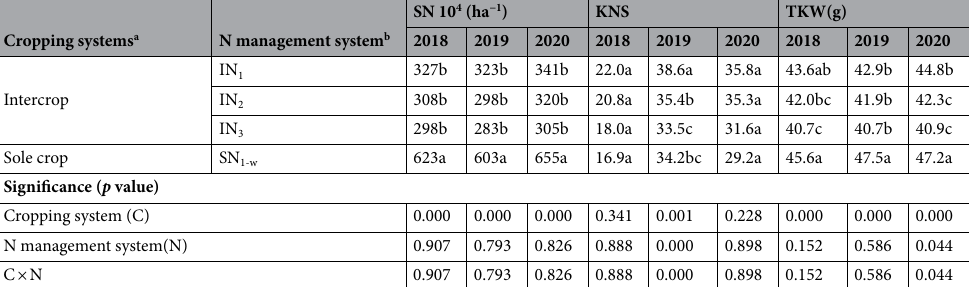
6.2–11.1% and 11.1–17.6% lower than sole maize. The SN of sole maize with the SN 1-m and SN 2-m were promoted by 8.5% and 7.0%, the KNS by 14.9% and 5.7%, and TKW by 5.7% and 3.5% compared with SN 3-m treatment, respectively. The same trend was found in intercropping maize. The SN of intercropped maize under IN 1 and IN 2 were 24.8% and 15.5% higher than IN 3 , the KNS were 12.0% and 7.7%, and TKW were 11.9% and 9.5%, respectively. Harvest index of wheat and maize. Harvest index (HI) of wheat and maize was significantly affected by cropping system and N-fertilizer treatment (except for wheat), but not by their interaction (Fig. 7). The HI of intercropped wheat with IN 1 and IN 2 was 5.9% and 2.6% greater than IN 3 , and of intercropped maize was 5.3% and 3.6% with IN 1 and IN 2 compared with IN 3 . The HI of sole maize with SN 1-m and SN 2-m was 6.9% and 3.9% higher than that of SN 3-m . The HI of sole wheat was lowest, only reached to 0.40. Among the three N treatments, IN 1 and IN 2 increased the HI of intercropped wheat and maize. Path analysis. The correlation coefficients between the grain yield and yield components were used to separate into direct and indirect effects via path analysis (Fig. 8A). The spike number (SN) and thousand-kernel weight (TKW) of wheat had the highest direct path coefficient and correlation coefficient than kernel number per spike (KNS). In addition, TKW had a positive indirect path coefficient with SN and SN had a positive indi- rect path coefficient with TKW, indicating that yield was influenced by the interaction between them. Although